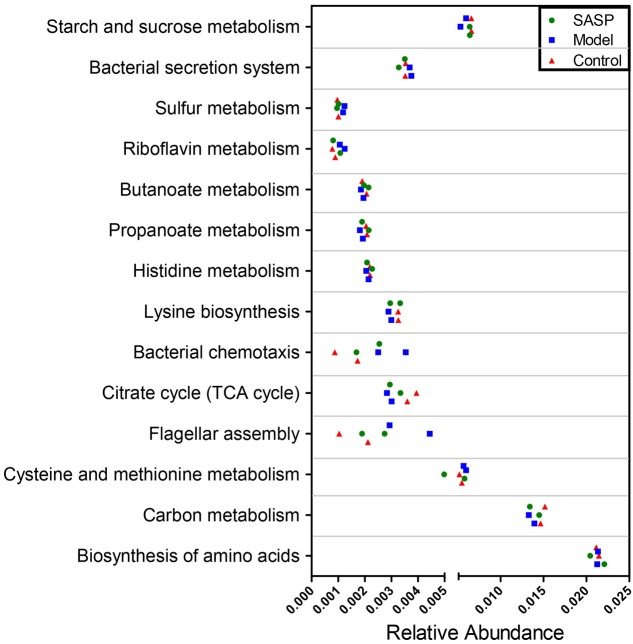
Shotgun sequencing validates the predicted microbial metabolic trends in a small subset of fecal samples from the different three groups (the control group, the model group, and the SASP group). A small subset of six stool samples were subjected to shotgun metagenomic sequencing via Hiseq 4000 platform. Of the 14 microbial metabolic modules, 11 retained the same under- or over-abundance trend predicted from 16S gene sequencing, excluding the biosynthesis of amino acids.